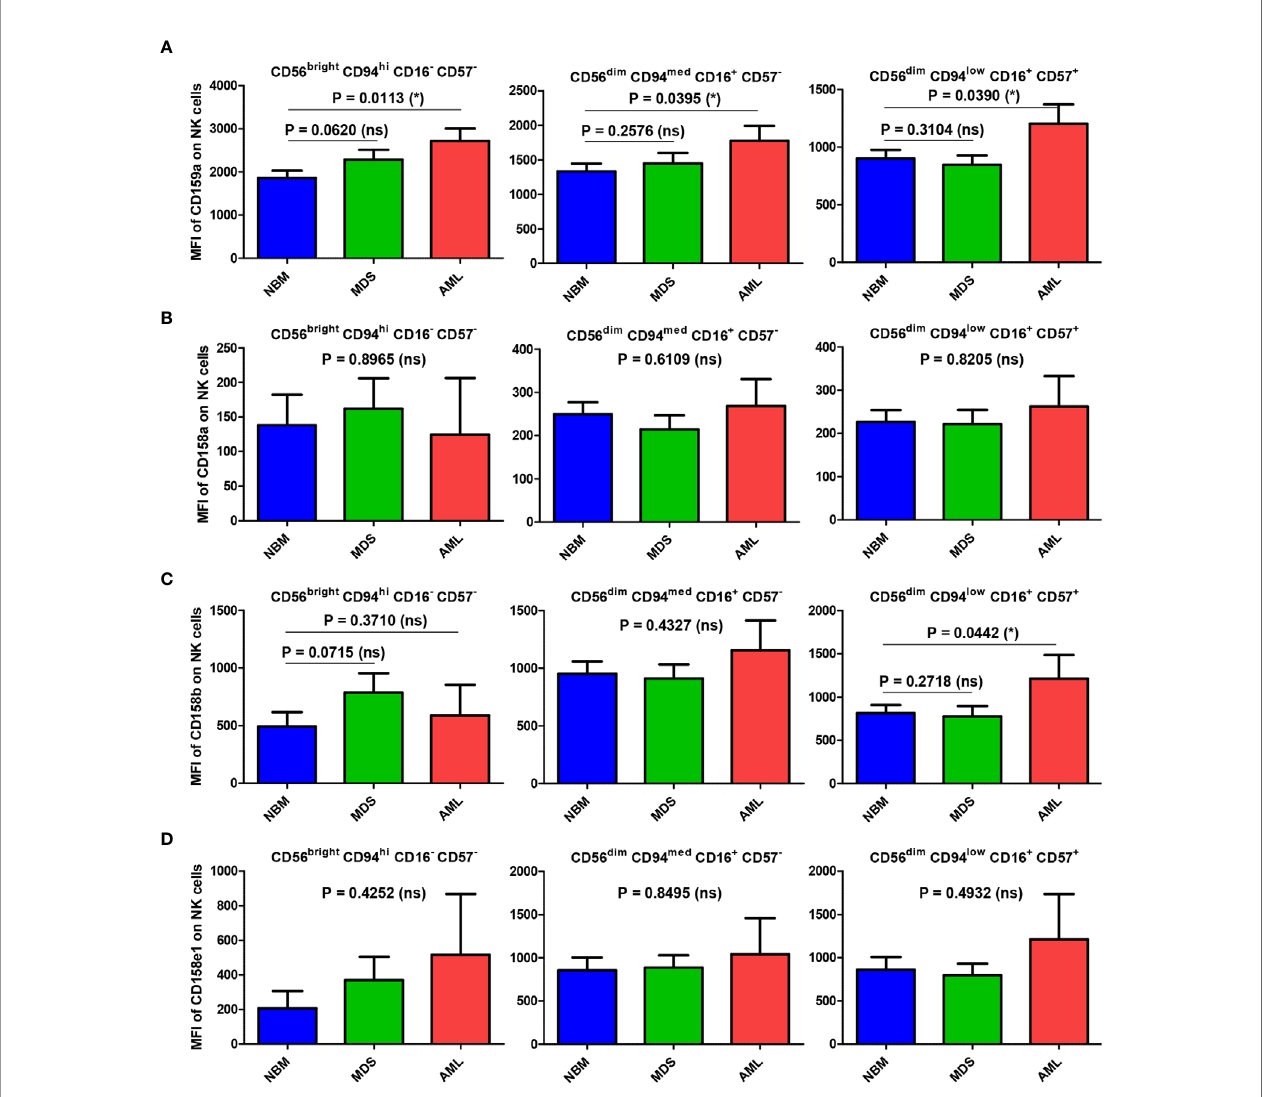
FIGURE 7 | Comparison of CD159a and KIR receptors mean fl uorescence intensities (MFI) of different NK maturation subsets within the bone marrow microenvironment of NBM, MDS, and AML cases. (A – D) Left panel: CD56 bright CD94 hi CD16 - CD57 - immature NK subset; middle panel: CD56 dim CD94 med CD16 + CD57 - mature NK subset; right panel: CD56 dim CD94 low CD16 + CD57 + hypermature NK subset; (A) CD159a MFI of different bone marrow NK maturation subsets in normal bone marrow (NBM, n = 30), myelodysplastic syndromes (MDS, n = 25), and acute myeloid leukemias (AML, n = 8) cases. Bars represent the mean ± SEM (*P < 0.05, ns, not signi fi cant; one-tailed unpaired t-test, and Mann Whitney test only for comparing the MFI means of mature NK subsets of NBM vs. MDS: Mann Whitney test). (B) CD158a MFI, (C) CD158b MFI, (D) CD158e1 MFI of different bone marrow NK maturation subsets in NBM (n = 30), MDS (n = 24), and AML (n = 8) cases. Bars represent the mean ± SEM (*P < 0.05, ns, not signi fi cant; one-way ANOVA followed by Tukey ’ s Multiple Comparison